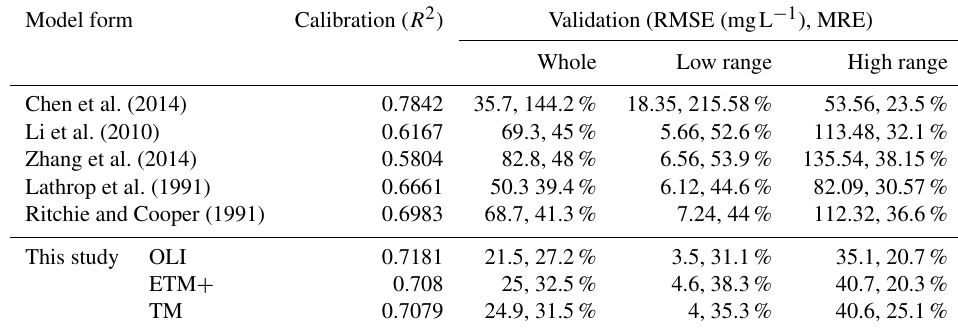
Table 3. The comparison of calibration and validation accuracy of several of the best TSS retrieval models.